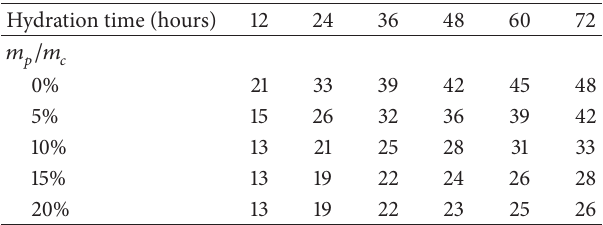
Table 4: Hydration degree of cement in different 𝑚 𝑝 /𝑚 𝑐 (%). Hydration time